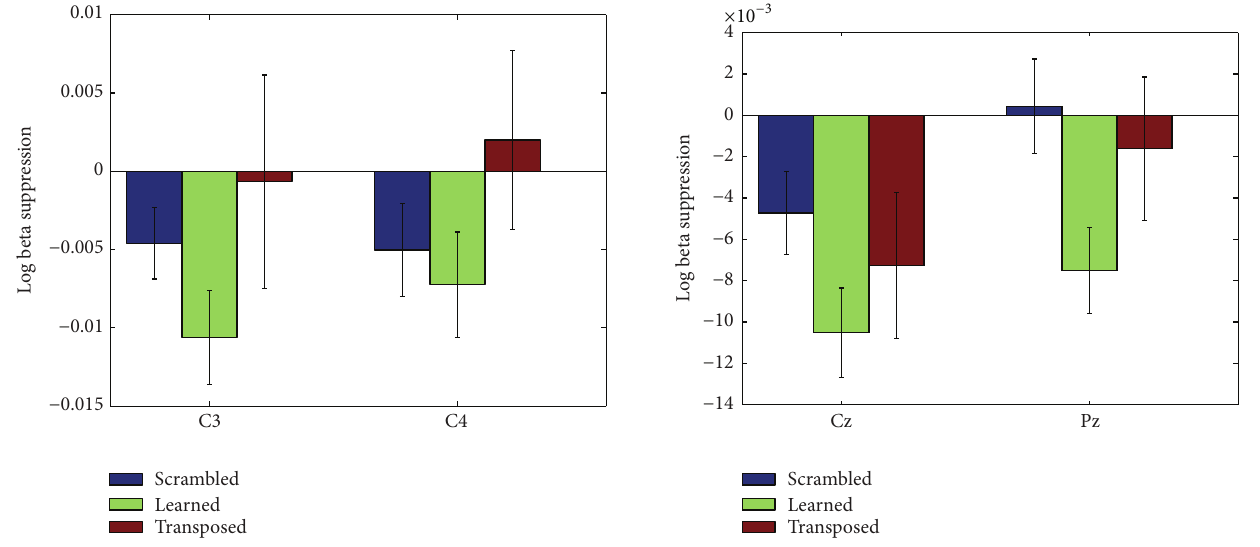
Figure 4: Beta suppression at electrodes C3 and C4. Error bars represent standard error of the mean.